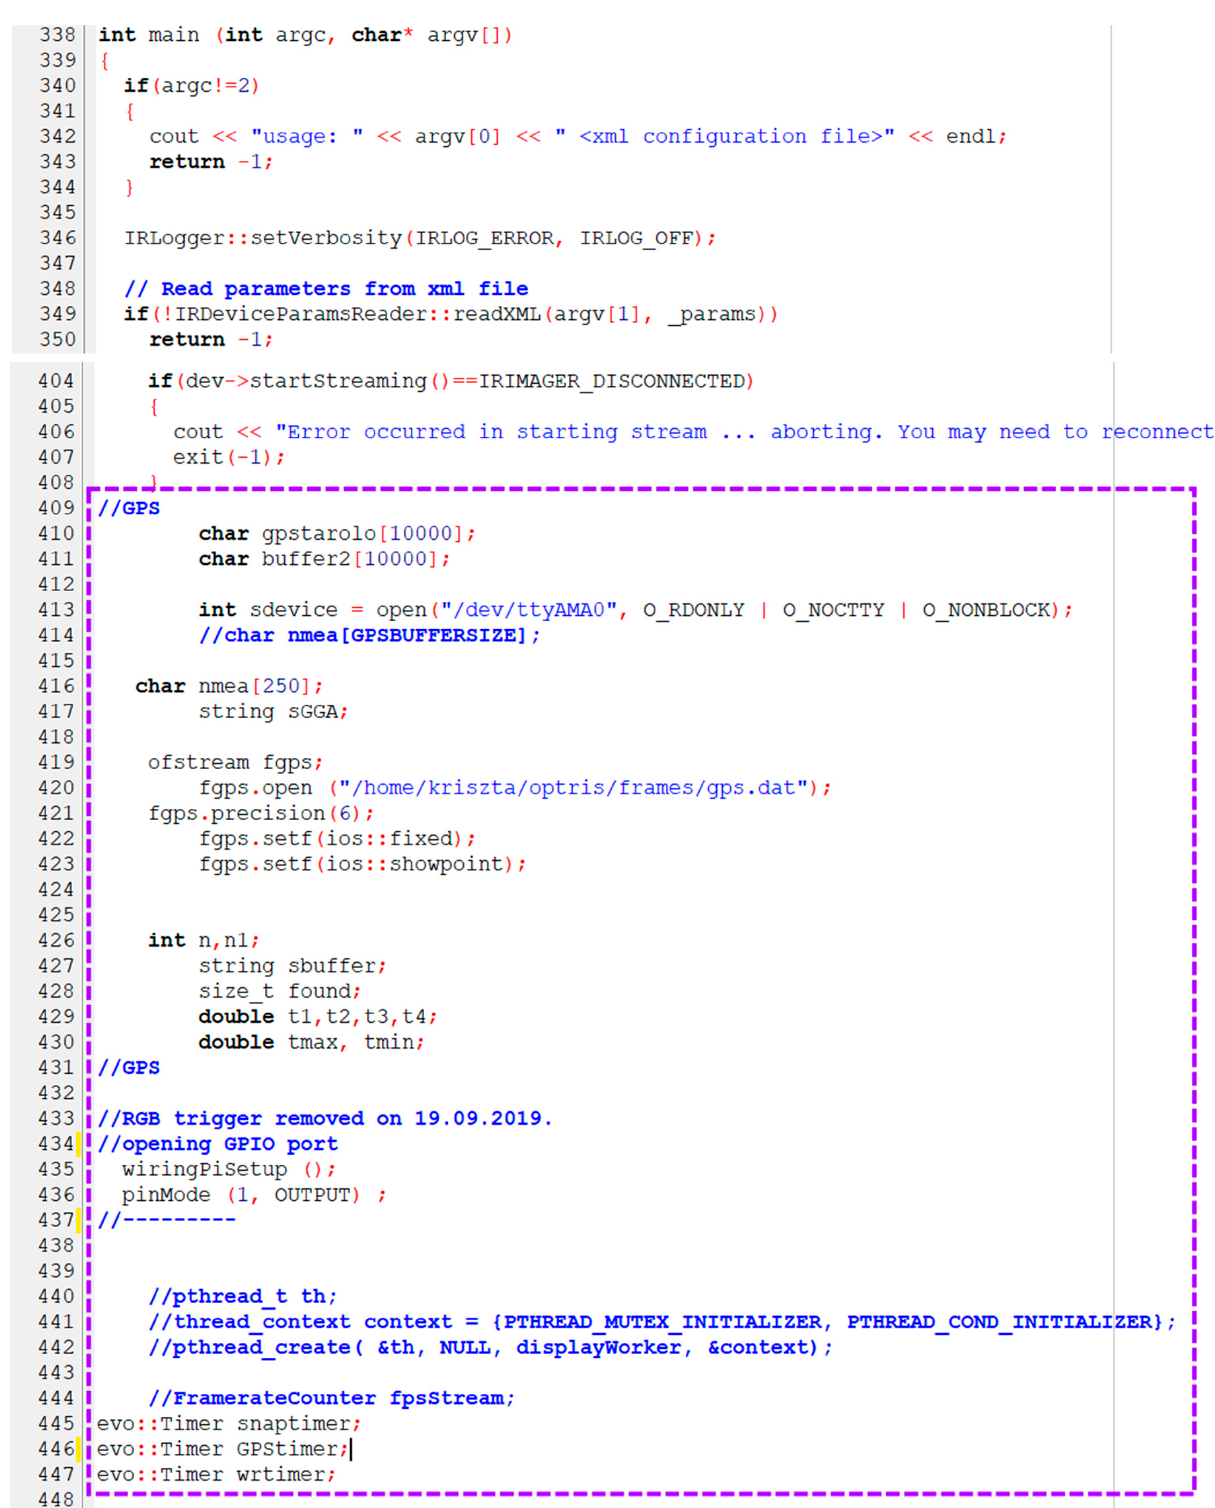
Figure A2. Controlling script of the thermal imaging system, part 2: Opening of the serial port and a text file output, reading the GNSS information, initialization of the GPIO 14 port and of built-in timers, declaration of the additional variables used in the script. The purple dashed frame highlights the inserted parts .